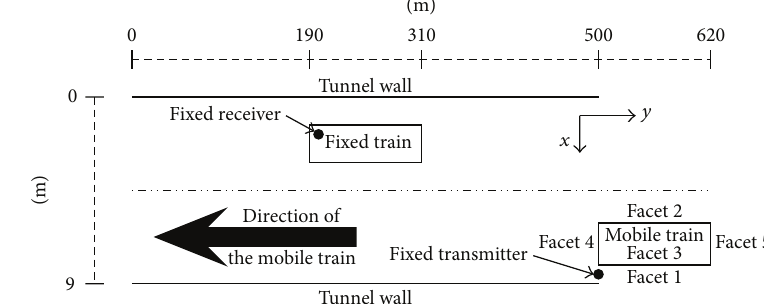
Figure 2: Description of the scenario.